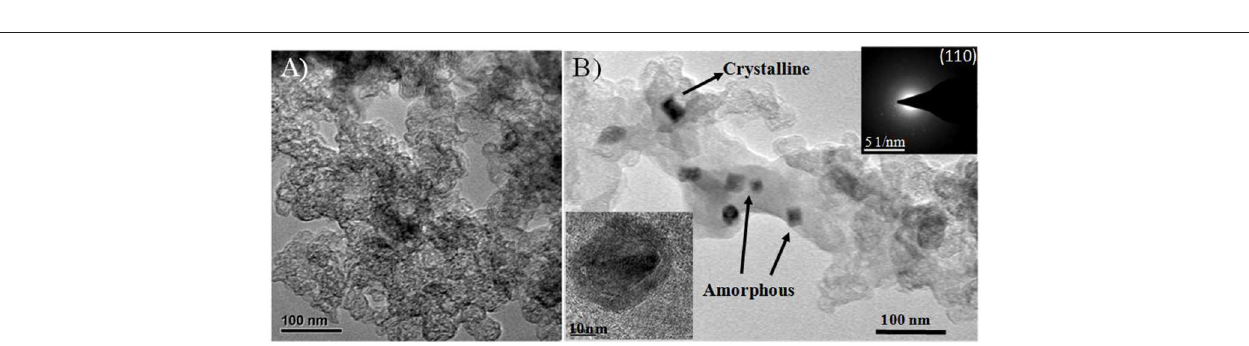
FIGURE 3 | Morphology characterization of dual heteroatom-doped electrocatalysts: (A) TEM image of the Fe/N/C, (B) TEM images of the Fe/N/C-S catalyst. The insets are the HR-TEM image of covered Fe particle and corresponding SAED pattern.